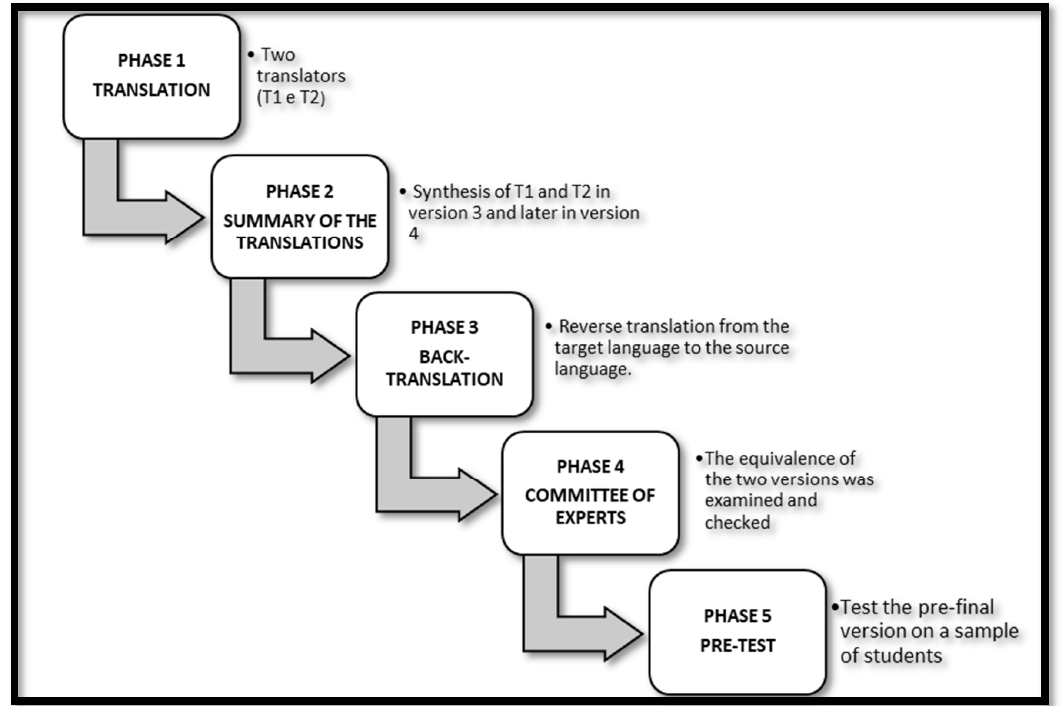
Figure 1. Guidelines for the transcultural adaptation of the RIPLS.